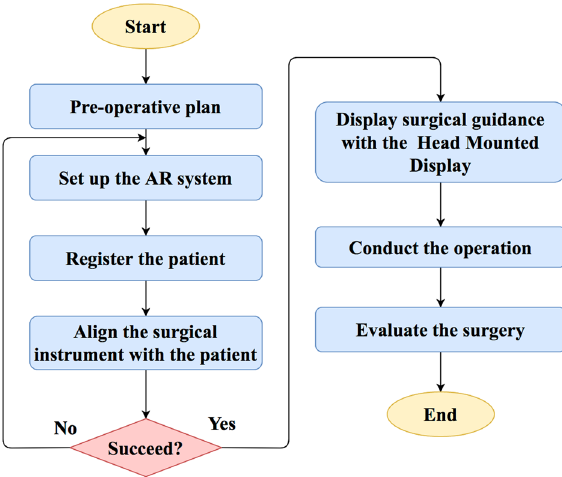
Figure 1. The workflow of the